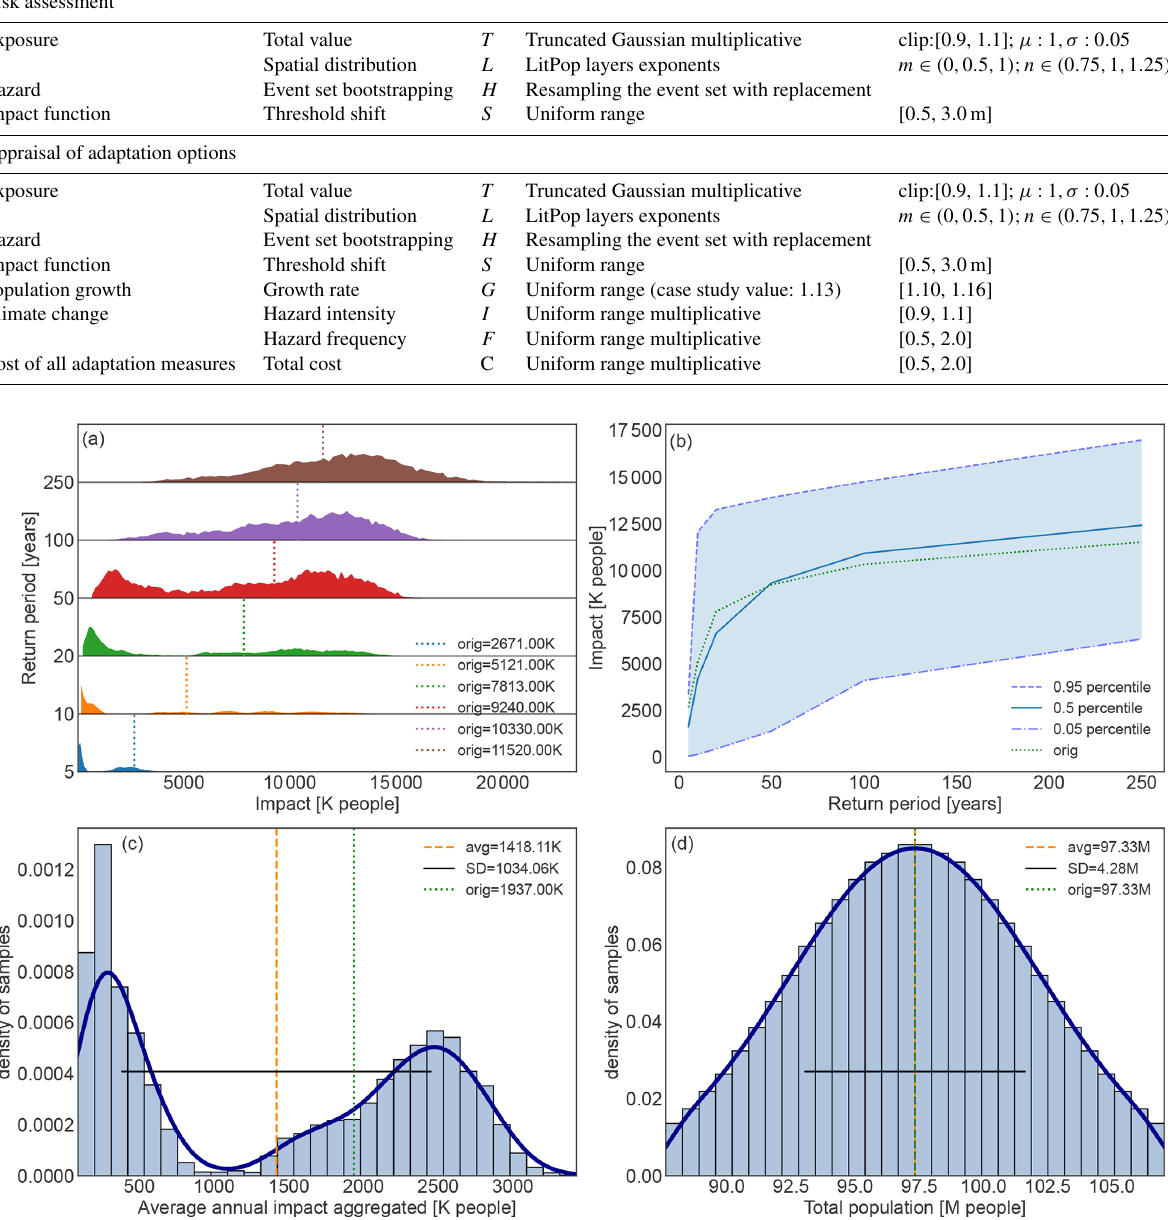
Figure 2. Uncertainty distribution for storm surge risk in terms of affected people in Vietnam for present climate conditions (2020). (a) Full range of the uncertainty distribution of impacted people for each return period (5 , 10 , 20 , 50 , 100 , 250 years) and value in the original study (vertical dotted lines). (b) Impact exceedance frequency curve shown for the original case study results (dotted green line), the median percentile (solid blue line), 5th percentile (dash-dotted blue line), and 95th percentile (dashed blue line). (c) Distribution of annual average impact aggregated over all exposure points (histogram bars) and (d) distribution of the uncertainty of the total population, i.e. the total exposure value, (histogram bars). Panels (c) and (d) both include the average value (vertical dashed orange line), original case study result (vertical dotted green line), standard deviation (horizontal solid black line), and kernel density estimation fit to guide the eye (solid dark-blue line). The impacts are expressed in thousands (K) or millions (M) of affected